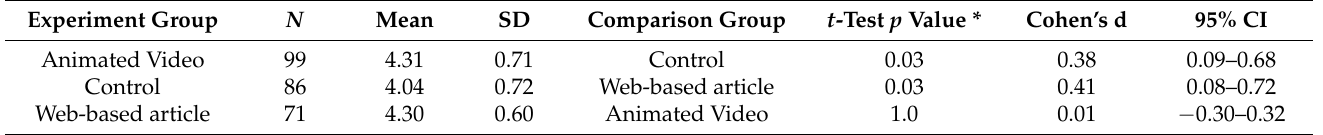
Table 5. Means, standard deviations, t -tests and Cohen’s d values across conditions on implementation feasibility following the interventions. The range of possible scores was 1—completely disagree (low feasibility) to 5—completely agree (high feasibility) across four statements that measured implementation feasibility.